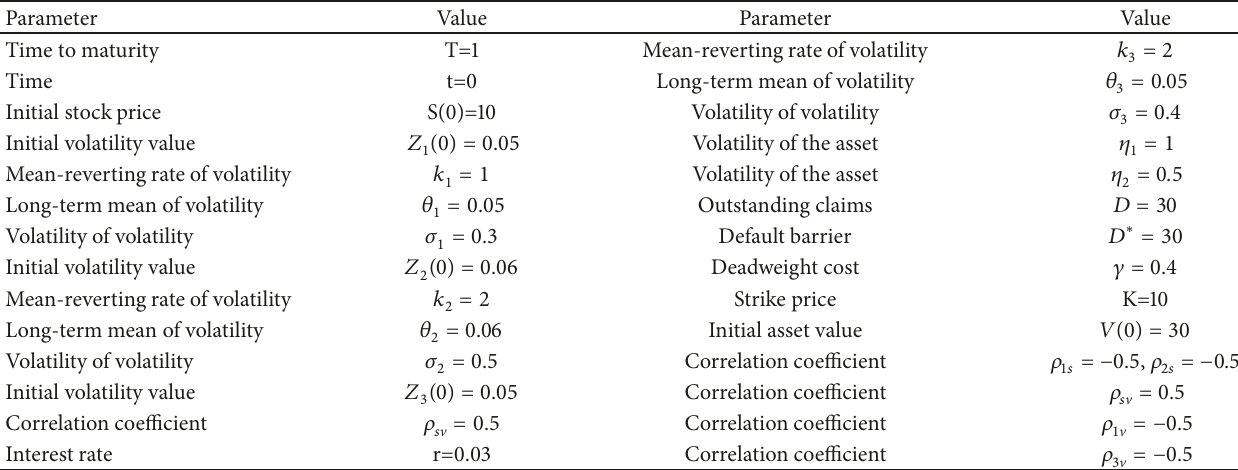
Table 1: parameter Values in the Base Case.